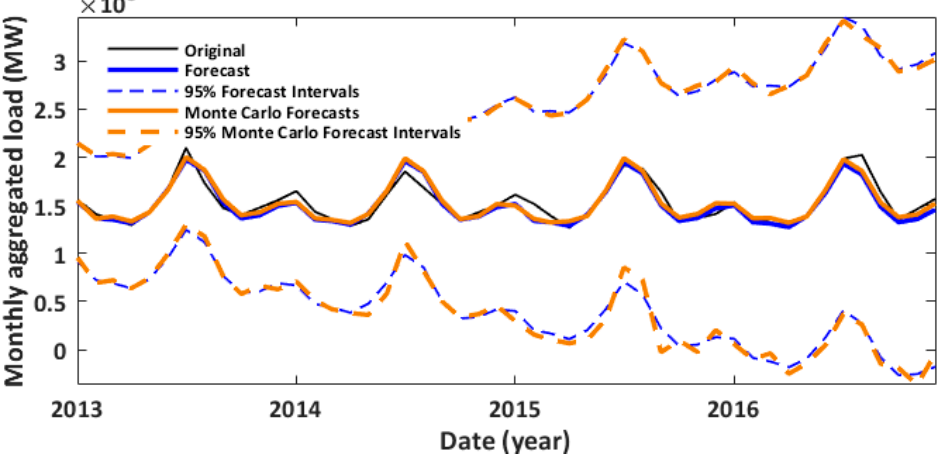
Figure 9. Out-of-sample forecast for years 2013–2016 with 95% confidence interval both upper and lower and a MAPE of 7.09%.